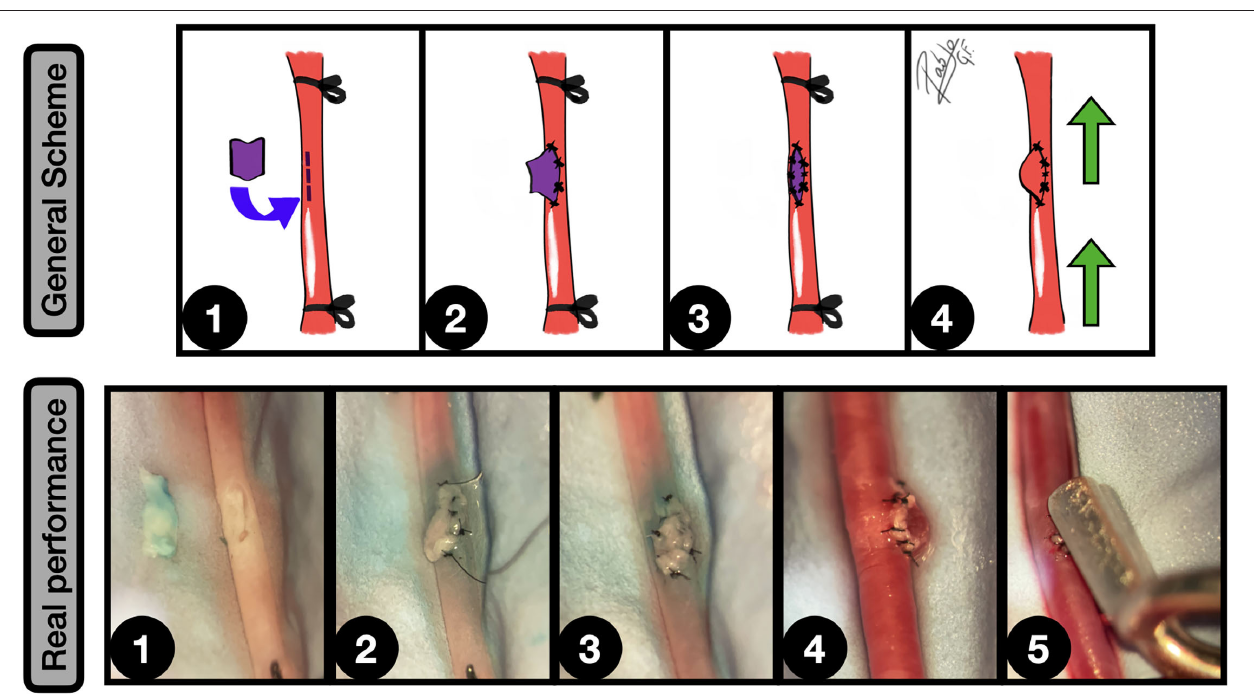
FIGURE 7 | No neck sidewall aneurysms model. General scheme: 1: CCA is exposed and proximal and distal ligated. A longitudinal arteriotomy in the lateral wall is performed and a plain venous graft from a jugular vein is harvested; 2: The graft is fixed to the arteriotomy edges by a couple of key anchoring knots; 3: The arteriotomy is totally covered by the venous graft in an end-to-side fashion; 4: After clamping releasing an inflow can be observed into the aneurysm. The green arrows indicate the blood flow direction. Real performance: 1: A longitudinal arteriotomy on the CCA anterior wall is performed. A plain venous graft, obtained from a jugular vein is shown on the left; 2: The graft is placed on the arteriotomy and fixed by some anchoring knots; 3: The graft is fully anastomosed on the arteriotomy, using interrupted stitches; 4: Clamps are released, appreciating a blood inflow into the graft, which simulates a no-neck sidewall aneurysm; 5: The aneurysm is clipped, preserving the parent vessel